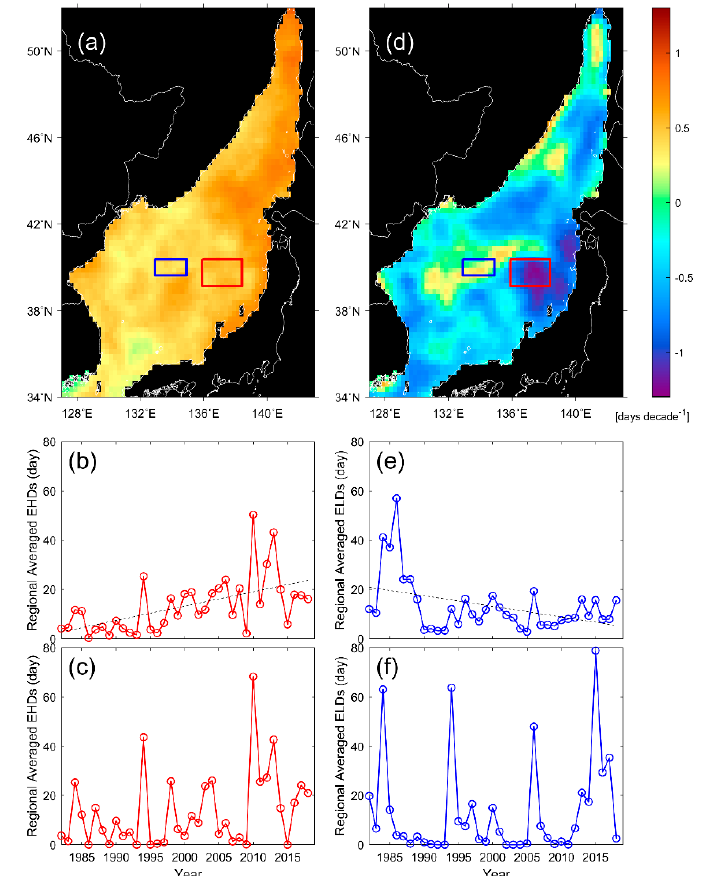
Figure 8. ( a ) Spatial distribution of trend of EHD occurrence frequencies, where blue (red) box represents the weak (strong) warming area; ( b ) time series of regional averaged EHD occurrence frequencies; ( c ) time series of regional averaged EHD occurrence frequencies in the weak warming area (blue box); and ( d , e , f ) same as ( a , b , c ) but for ELD, where the dashed lines of ( b ) and ( e ) are y = 0.58x − 1151.10 and y = − 0.43x + 875.41, respectively.